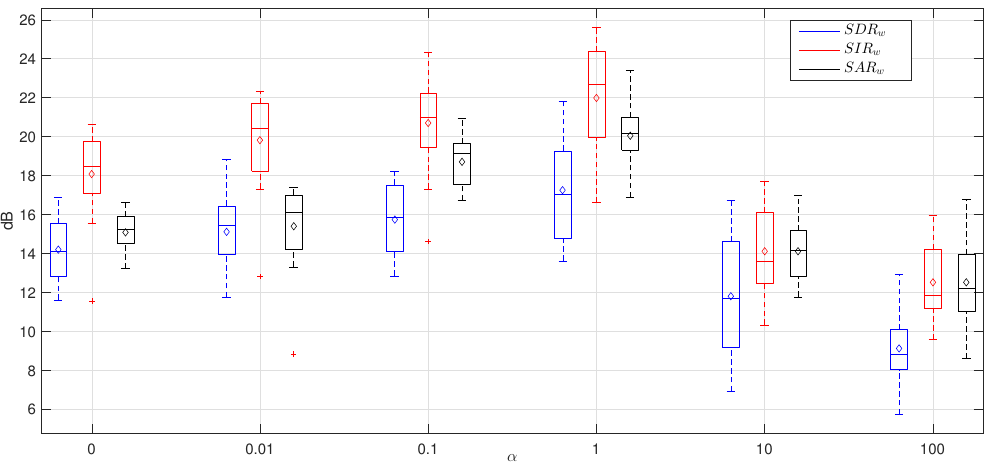
Figure 6. SDR w , SIR w and SAR w average results from the hyperparametric optimization of the proposed method varying the parameter α . The rest of parameters are the following: K W = 64, K R = 32, λ 0 = 0.1 and λ = λ 1 W R